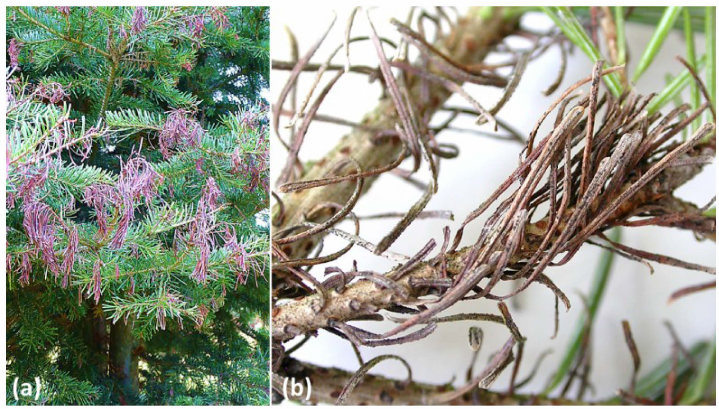
Figure 3. Delphinella abietis on subalpine fir ( Abies lasiocarpa ) in the provenance trial at at Jønsberg in 2015. ( a ) Dead needles on current year shoots in September; ( b ) small, black fruiting bodies on needles in March. Photos: Venche Talgø.